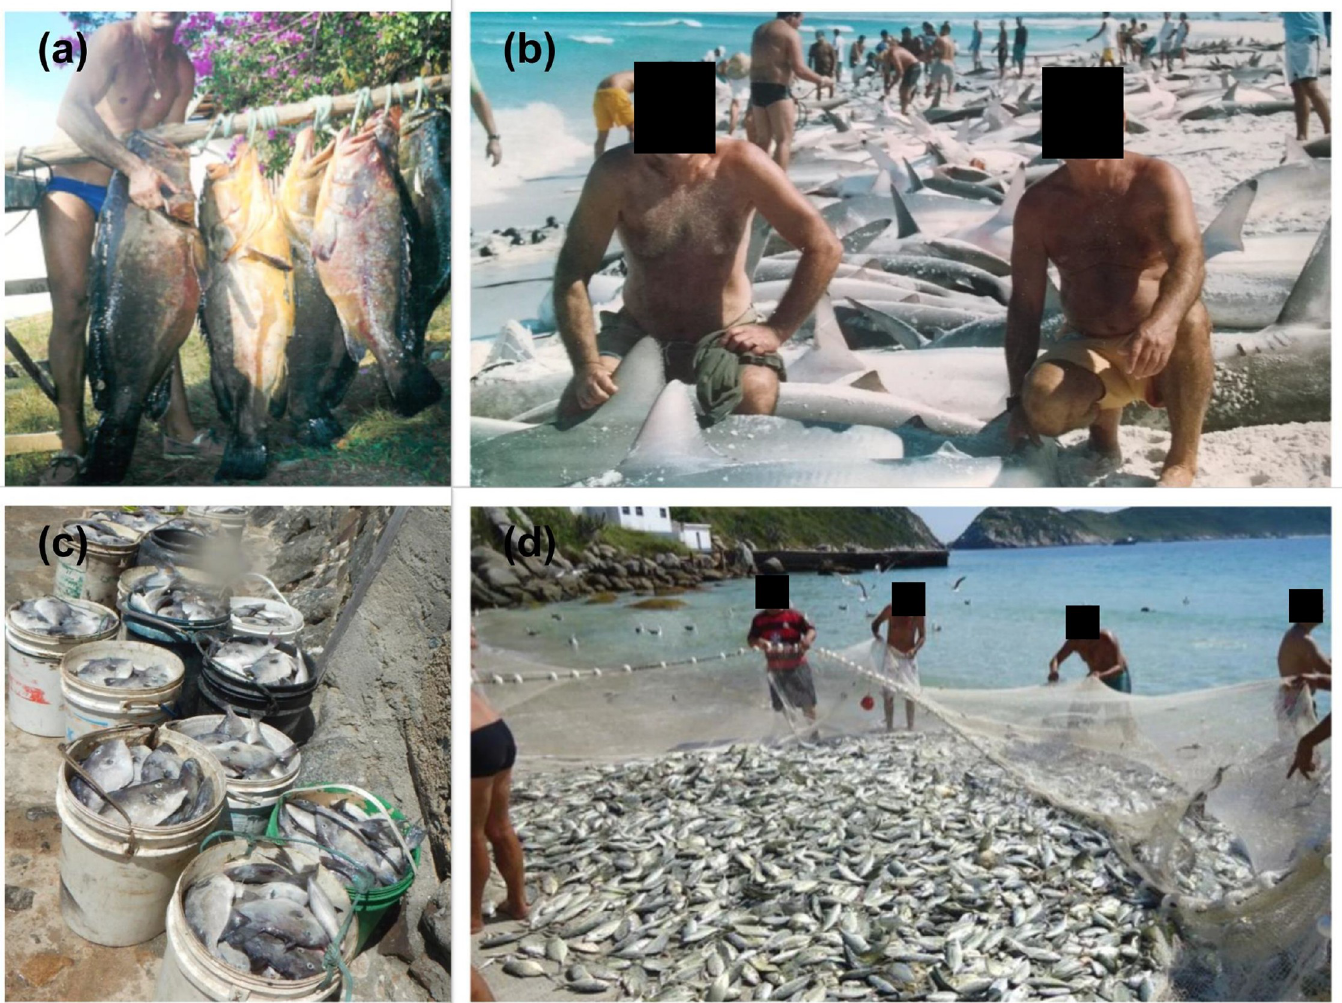
Fig 6. Photographs showing past and present catches of species mentioned by fishers as overexploited and new target species in Arraial do Cabo: (a) Epinephelus marginatus in 1982; (b) Carcharhinus brevipinna caught in Praia Grande in 2005; (c) Balistes capriscus and (d) beach seine fishing at Praia Grande recorded in 2020.